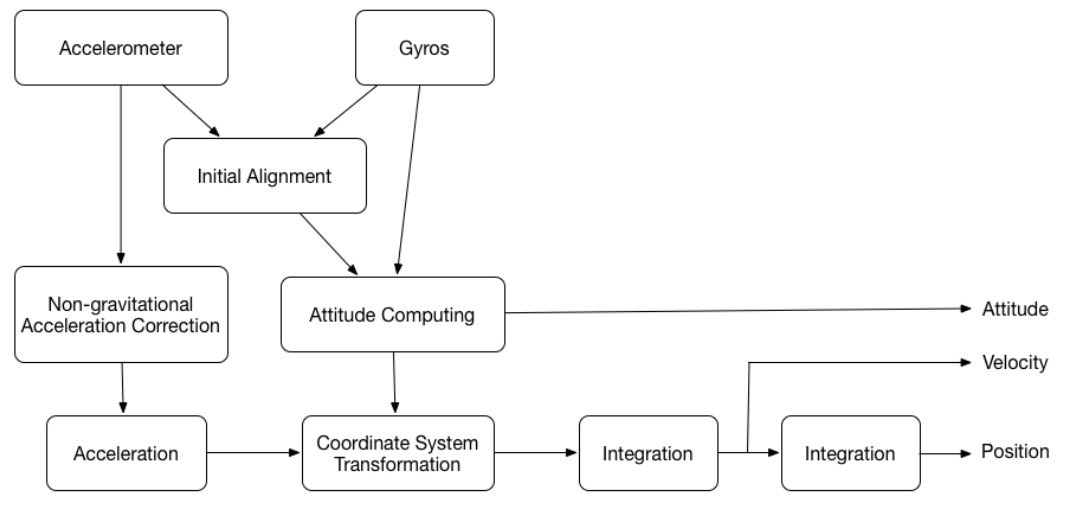
Figure 3. Inertial Navigation Systems (INS)